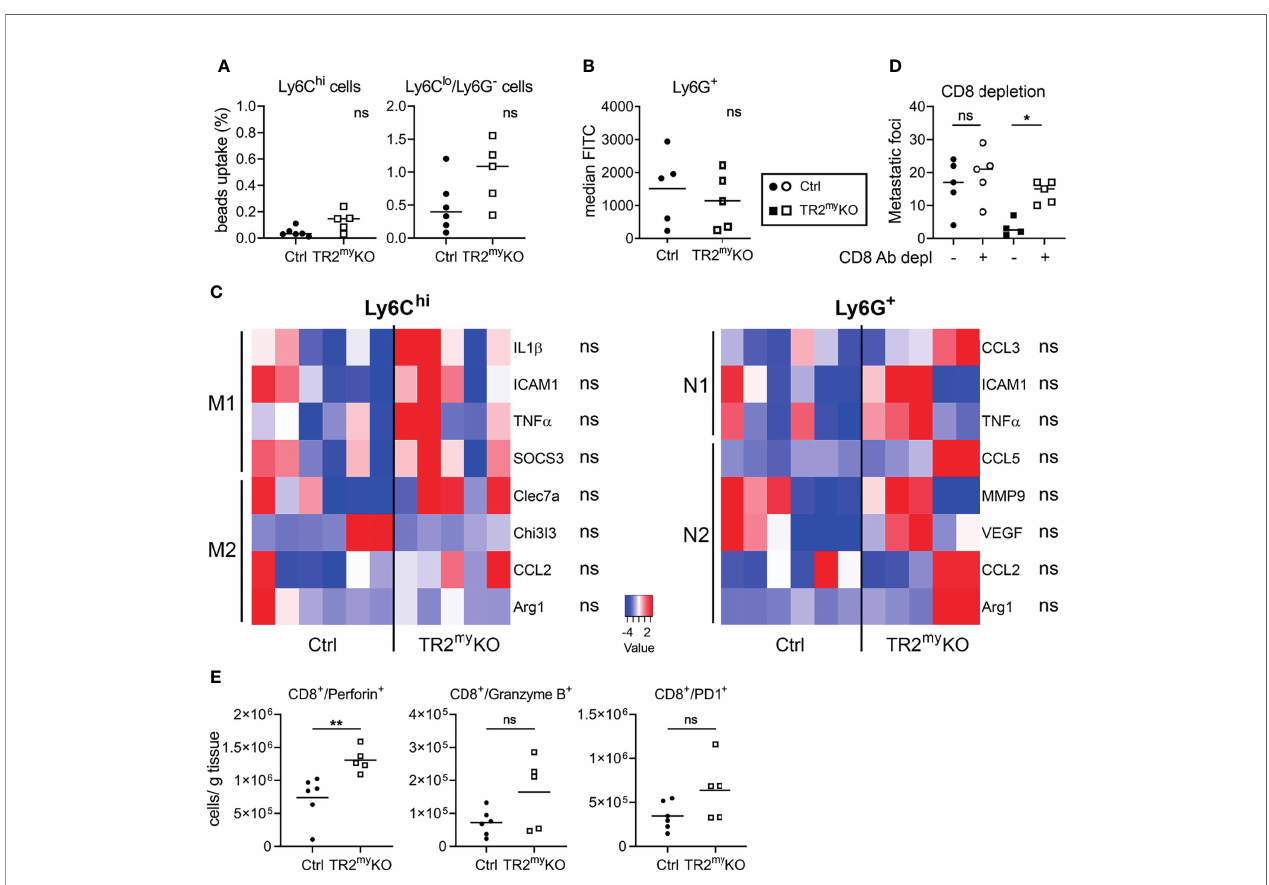
FIGURE 6 | Lung metastasis in Tgfbr2 -myeloid cell-de fi cient mice are controlled by CD8 cells. Characterization of myeloid cells from TR2 my KO and Ctrl mice at day 21 (early metastatic lungs) post-subcutaneous injection of LLC1.1 cells. (A) The phagocytic capacity of Ly6C hi monocytes and Ly6C lo /Ly6G - macrophages isolated from metastatic lungs 9 hours after the intravenous injection of fl uorescent beads. (B) Reactive oxygen species (ROS) levels in neutrophils isolated from the lungs of mice perfused with the CellROX ® dye in vivo . Data are presented in median fl uorescent intensity (MFI). (C) Gene expression analysis of Ly6C hi /tdT + monocytes and Ly6G + /tdT + neutrophils sorted from metastasis lungs of tdT-reporter TR2 my KO and Ctrl mice at day 21 post-tumor cell injection and 5 days after the tumor removal performed by qPCR. A panel of genes associated with M1 and M2 macrophage polarization and N1 and N2 neutrophil polarization was analyzed. (D) Spontaneous lung metastasis of LLC1.1 cells upon anti-CD8 antibody or isotype control depletion in TR2 my KO and Ctrl mice. Mice were terminated at day 32, and lung metastasis quanti fi ed. (E) Analysis of effector CD8 + cells from metastatic lungs at day 32 in a spontaneous lung metastasis model LLC1.1 using fl ow cytometry analysis for detection of perforin, granzyme B and PD-1. Statistical signi fi cance was assessed using Mann-Whitney test: ns, not signi fi cant; *p < 0.05; **p <